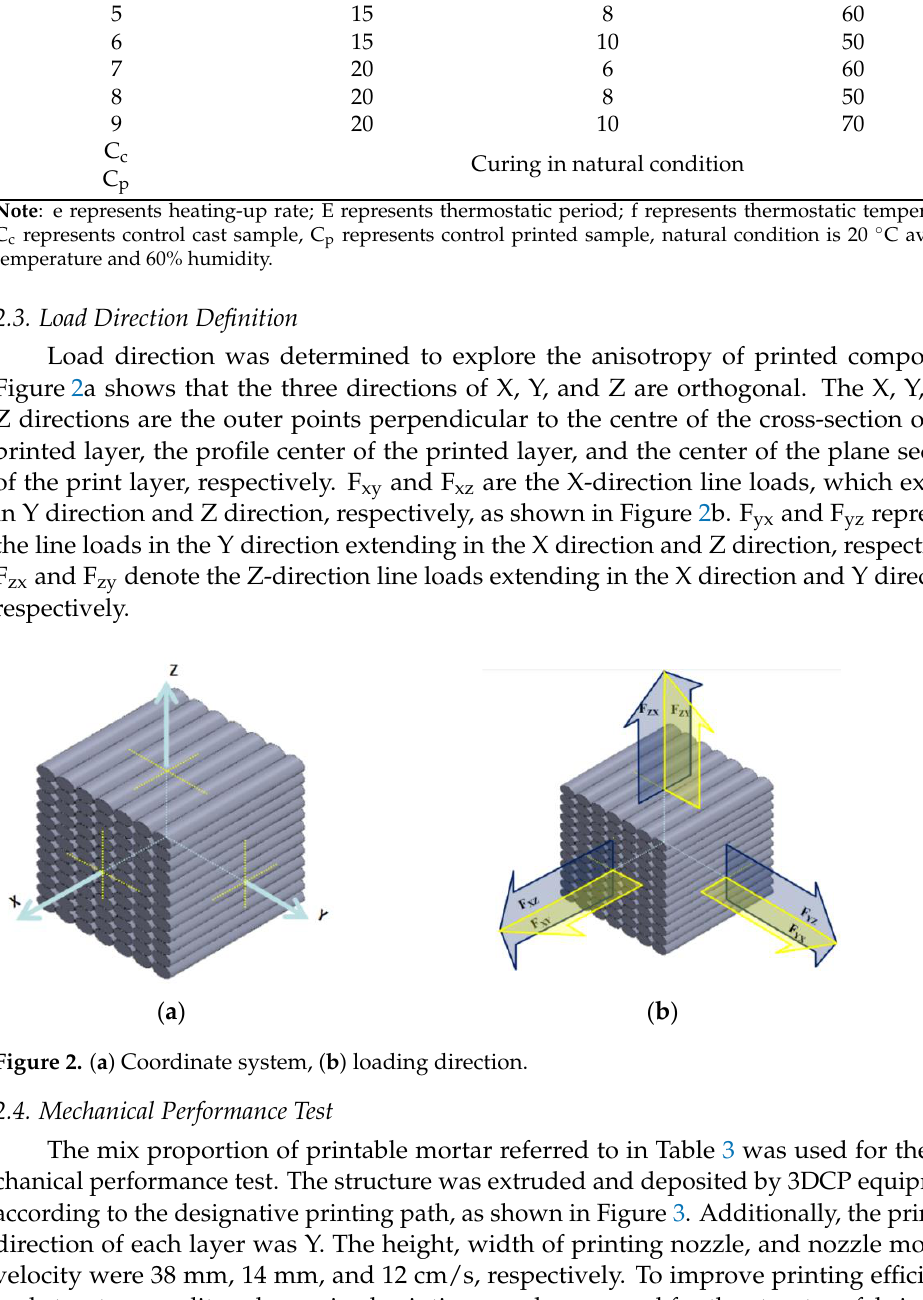
Table 3. Control mix proportion of this test.